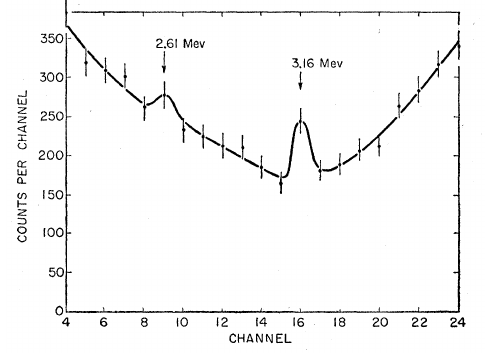
Figure 8: The very nice discovery of the energy levels by Beghian et al (1953). of  rays as discovered by Beghian et al. 1953.